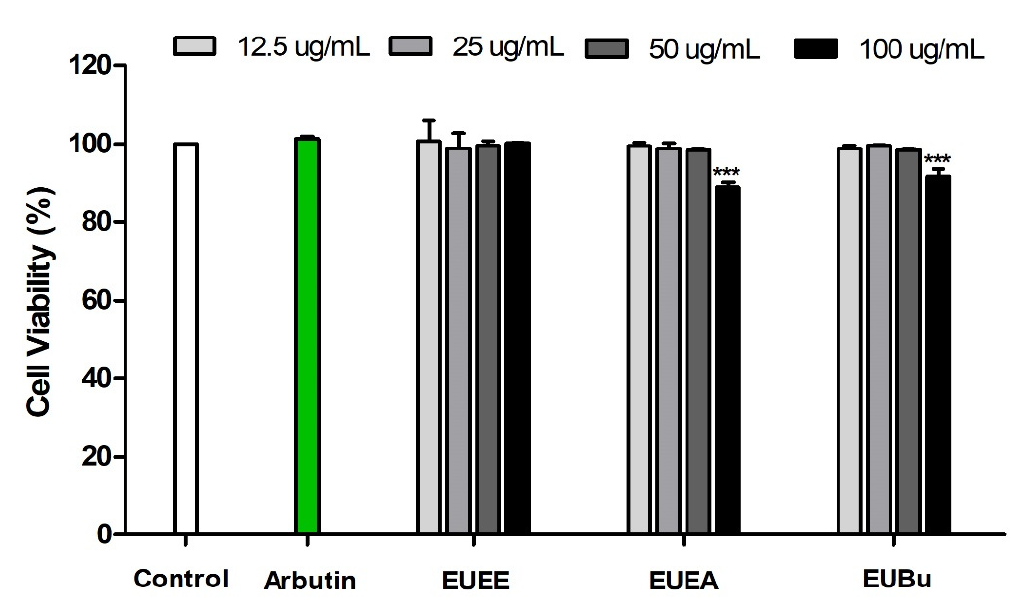
Figure 3. Cell viability of EU. Cell viability in B16-F10 melanoma cells of EUEE, EUEA, and EUBu. All graphs show percentages of control, and data expressed as means ± S.E.M. (n = 3). Statistical significance was set at *** p < 0.001 when compared with the control.